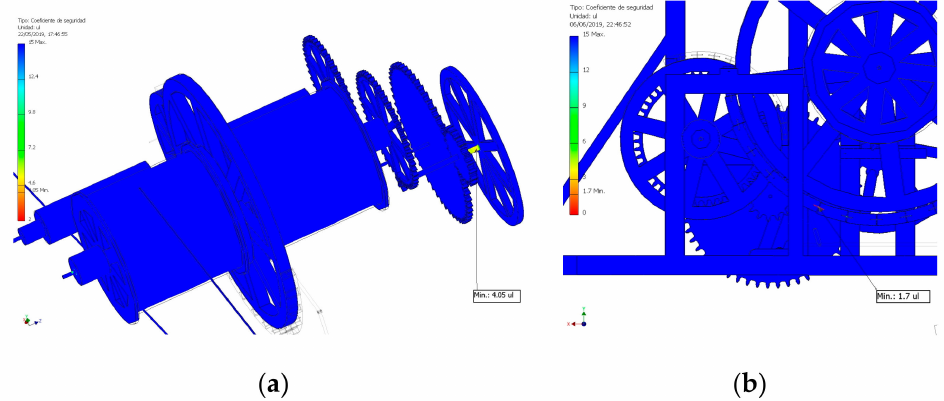
Figure 22. Location of the second lowest safety coefficient: ( a ) blockage situation and ( b ) braking